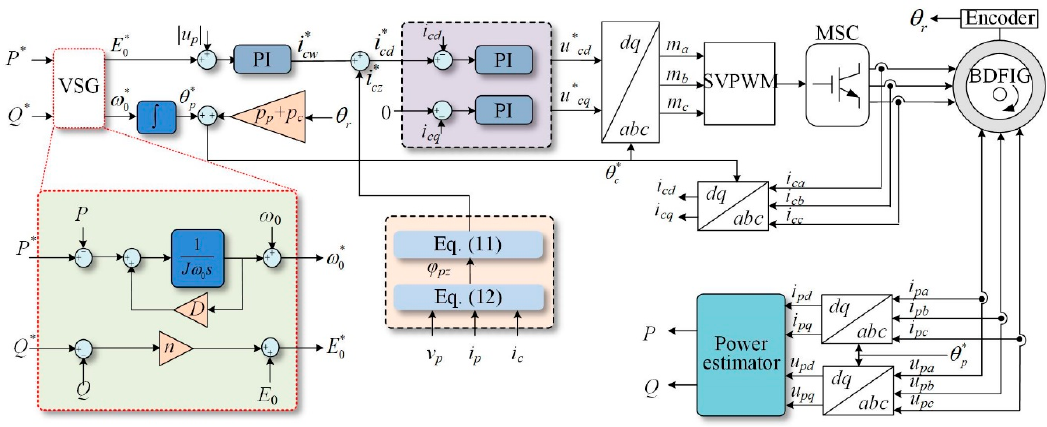
Figure 5. The proposed control block diagram.